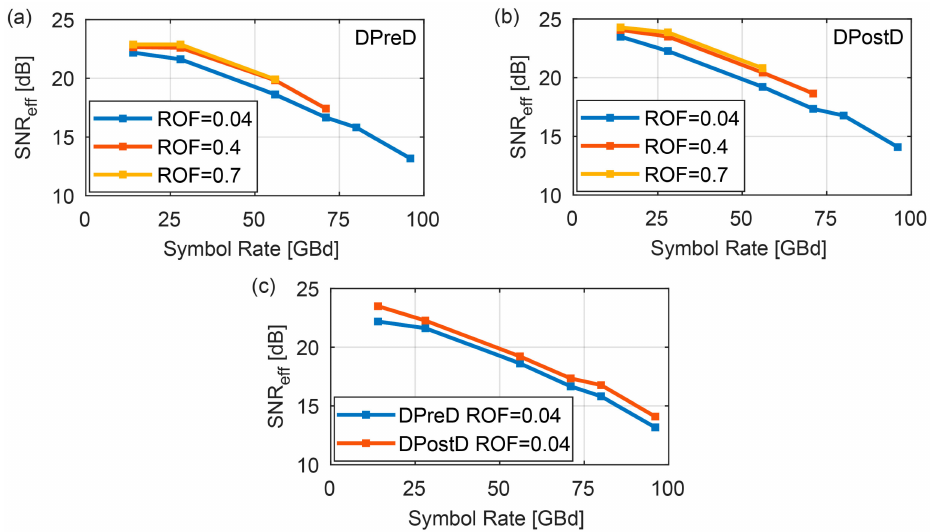
Figure 7. SNR improvement due to DPostD. Dependence of effective SNR on the symbol rate and ROF with DPreD ( a ) and with DPostD ( b ). ( c ) Comparison of effective SNR with an ROF of 0.04 with DPreD in blue and DPostD in red. The measured symbol rates are 14, 28, 56, 71, 80, and 96 GBd; QPSK was used as the modulation